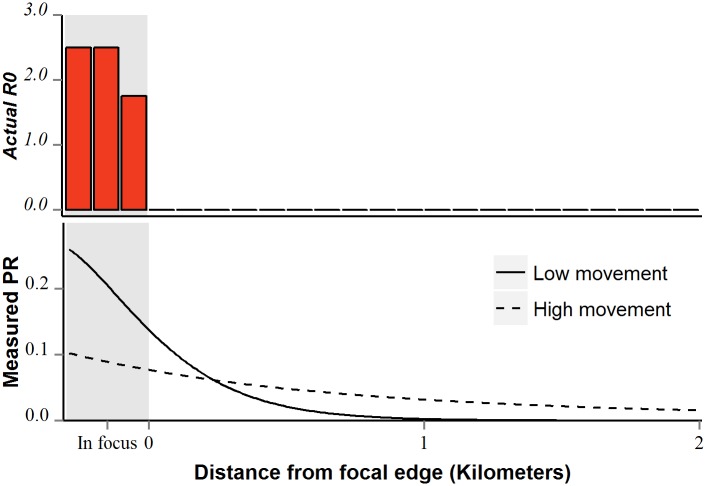
Hypothetical observed fraction of people infected with malaria (parasite rate) within and near malaria foci.Transmission only occurs within focal areas (top panel). Observed parasite rate shown in bottom panel with varying distances travelled. As humans move further and/or more frequently from within focal areas, they export parasites, causing larger extra-focal extents to exhibit nonzero parasite rate (dotted line; bottom panel).